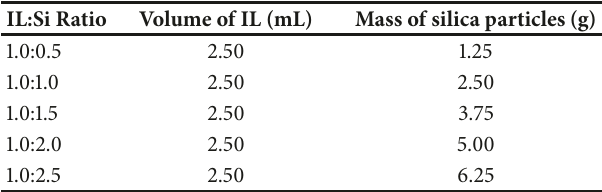
Table 1: IL:Si ratios